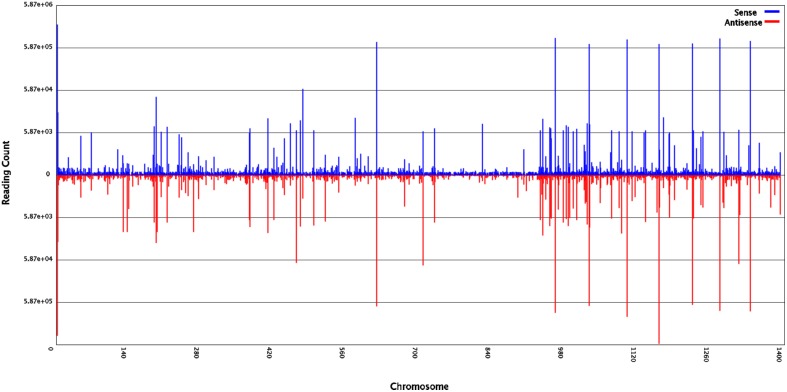
Small RNAs of ponkan in vitro plantlet leaf distribution across different ponkan chromosomes.